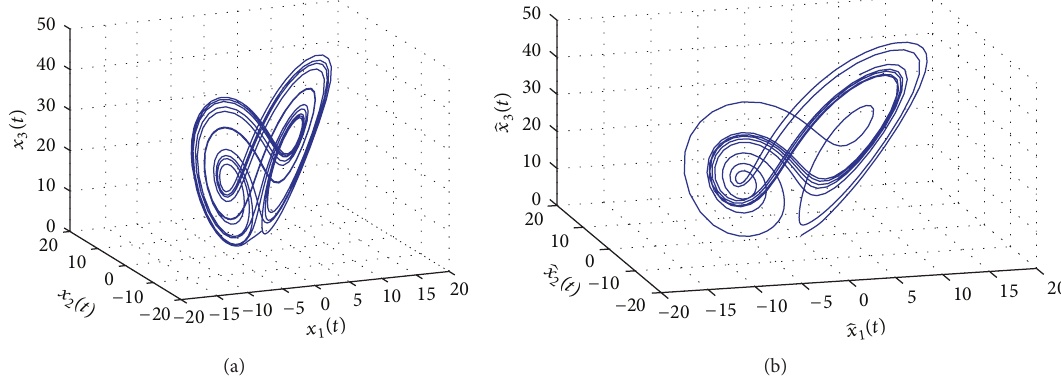
Figure 2: (a) Chaotic behavior of the master system (38). (b) Chaotic behavior of the slave system (39) without